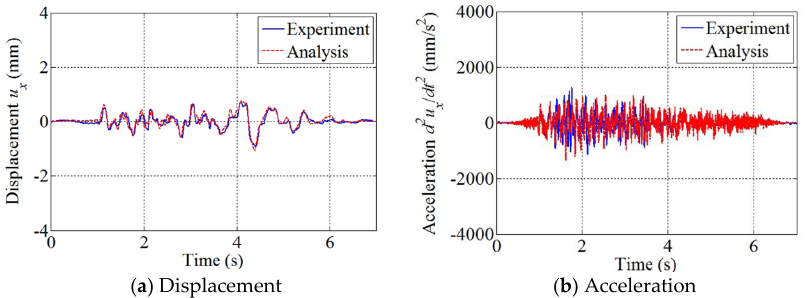
Figure 19. First-floor response in the x direction due to the low-intensity ground motion; responses sampled at point A.